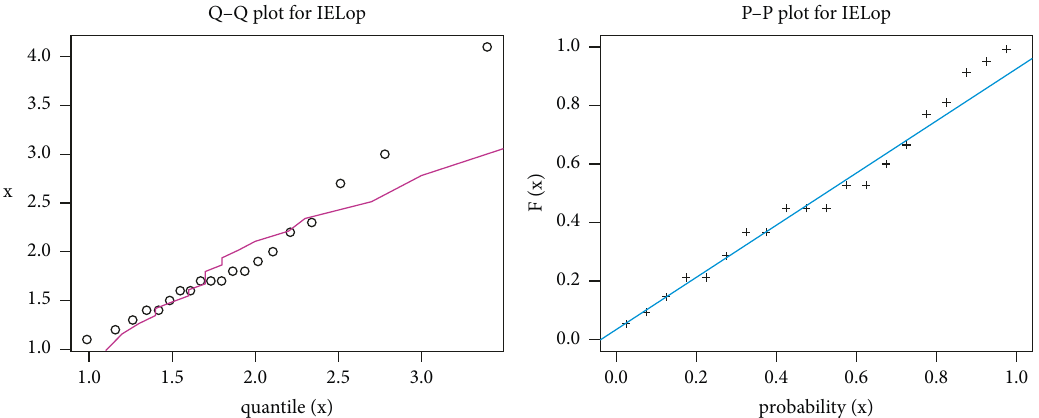
Figure 6: P-P plot and Q-Q plot for IELoP distribution for dataset I.